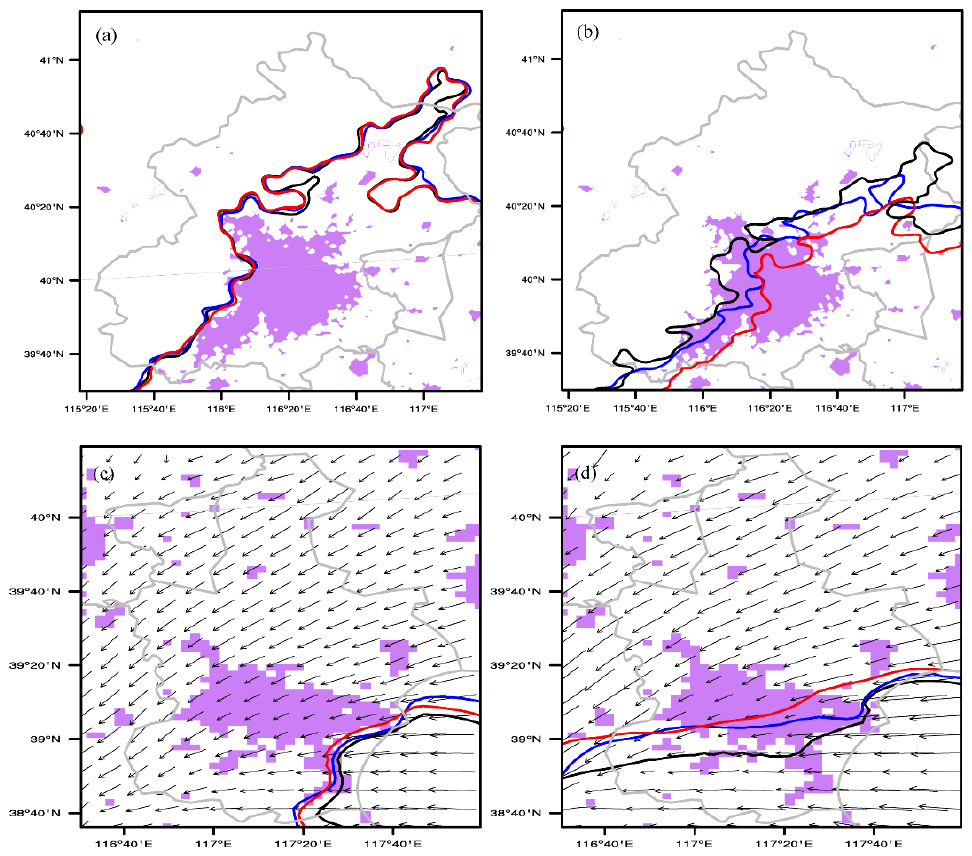
Figure 6. The 22 °C isotherm in the Urban16 test (black line), Urban06 test (blue line), and No urban test (red line): ( a ) 00:00 UTC on 20 July; ( b ) 03:00 UTC on 20 July. The 18 g kg −1 specific humidity line in the Urban16 test (black line), Urban06 test (blue line), and No urban test (red line): ( c ) 22:00 UTC on 19 July; ( d ) 01:00 UTC on 20 July. The purple shading shows the urban area of the Urban16 test.